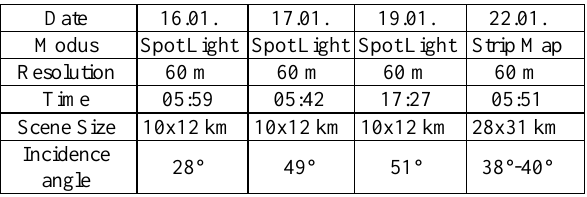
Table 1: TS-X acquisition parameters on measurement